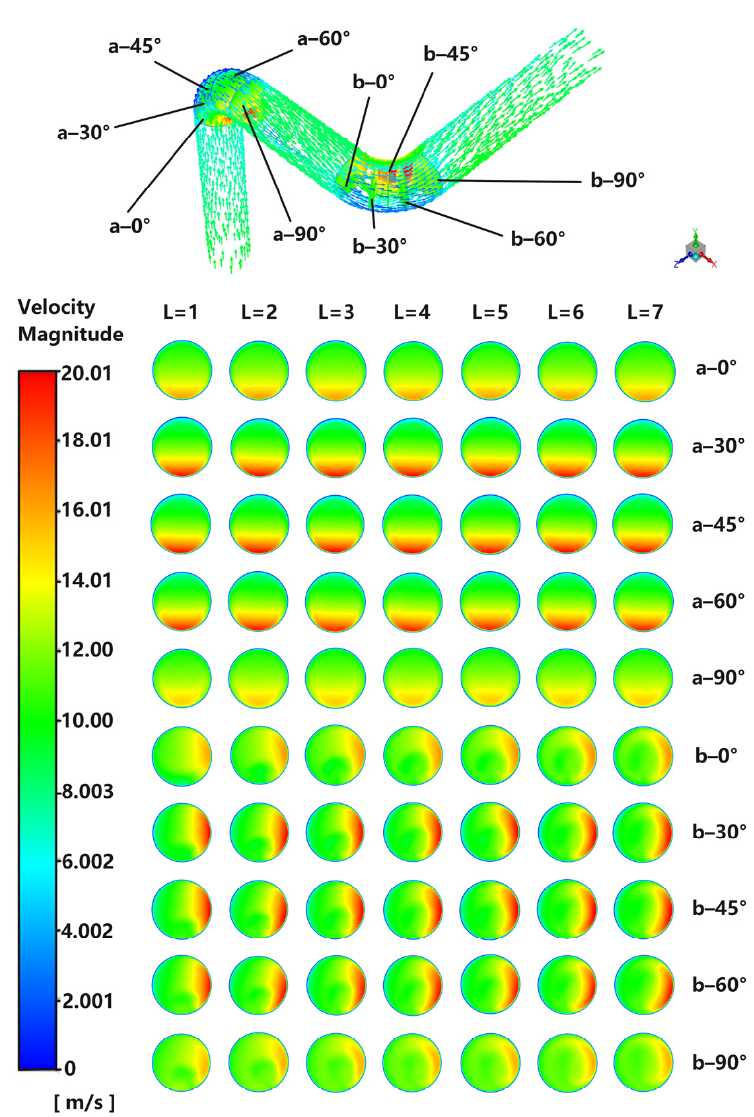
Figure 7. Position diagram of iso-surfaces and velocity distribution contours with vectors.